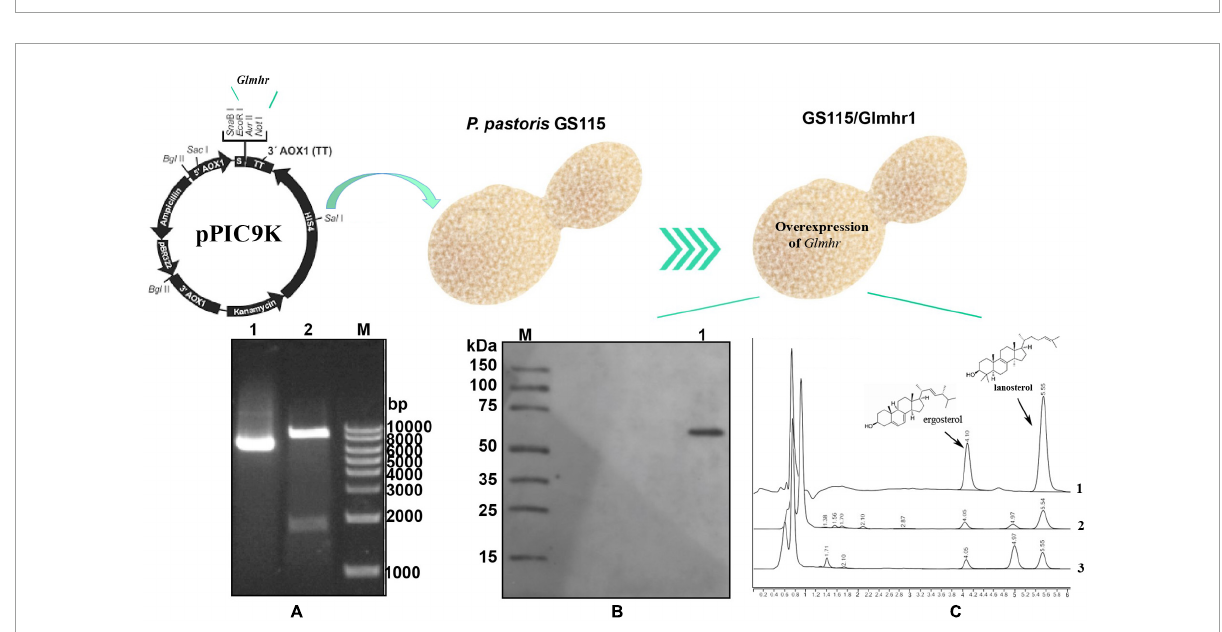
FIGURE5 Over expression of Glmhr1 gene. (A) Verification of the recombinant plasmid pPIC9k/Glmhr1. M: Maker; 1: plasmid pPIC9k/Glmhr1; 2: Xho I/ Not I- digested plasmid pPIC9k/Glmhr1. (B) Western blotting analysis. M: Maker; 1: positive colony. (C) Determination of the content of lanosterol and ergosterol. 1: standard; 2: strain GS115; 3: strain